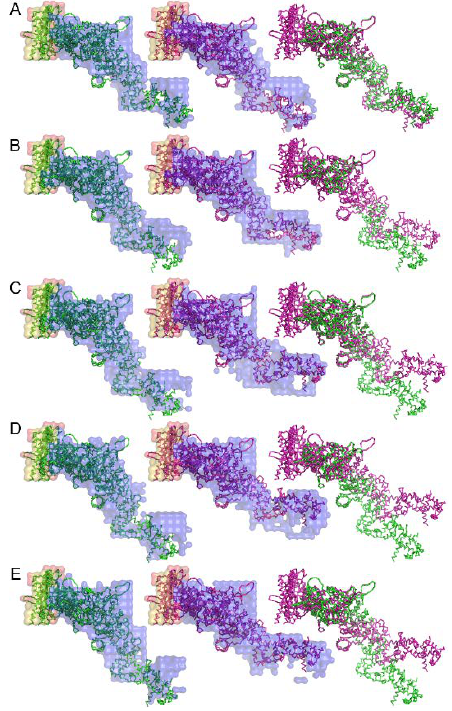
Figure 11. Structure of the complex between myosin S1 (subfragment-1) fragment and actin restored from diffraction patterns. The sources of S1 are: ( A ) rabbit fast skeletal, ( B ) rabbit cardiac/slow skeletal, ( C ) chicken gizzard smooth, ( D ) human nonmuscle IIA, and ( E ) human nonmuscle IIB. The green and purple amino-acid backbones are the best-fit structures for the electron-density envelope of the rigor and ADP-bound complexes, respectively. Taken from Reference